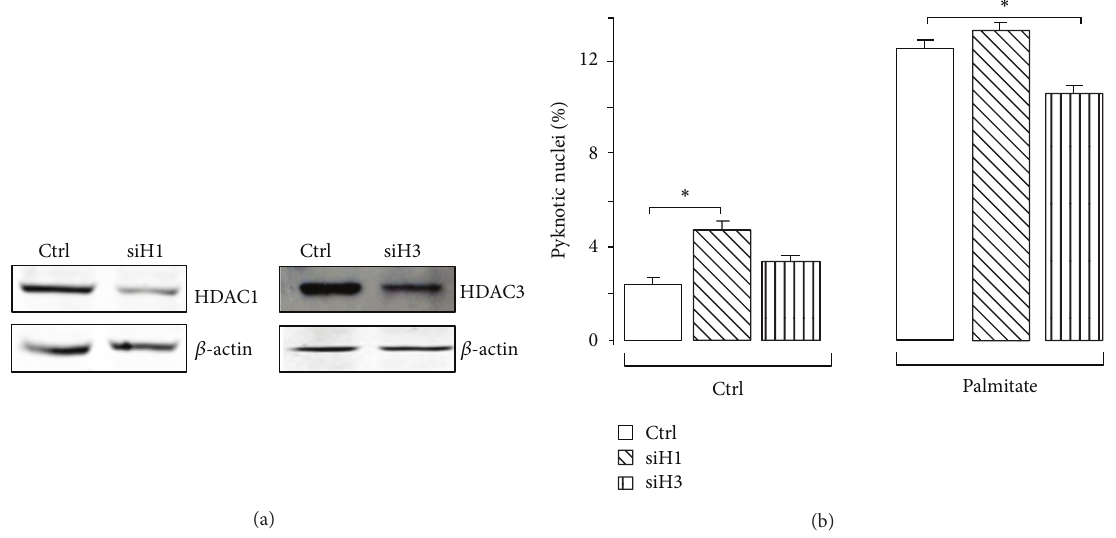
Figure 3: Impact of HDAC1 and HDAC3 silencing on apoptosis evoked by palmitate. (a) Western blotting analysis of HDAC1 and HDAC3 abundance and (b) measurement of apoptosis upon silencing of HDAC1 and HDAC3 in MIN6 cells. Cells were transfected with the siRNAs directed against either HDAC1 (siH1), HDAC3 (siH3), or GFP (ctrl). Palmitate was added 24 hrs after transfection. Nuclear proteins were prepared and pyknotic nuclei were counted 48 hrs later. The immunoblotting was achieved using the anti-HDAC1, anti-HDAC3, and anti- 𝛽 - actin antibodies. The figure shows the result of a representative experiment out of